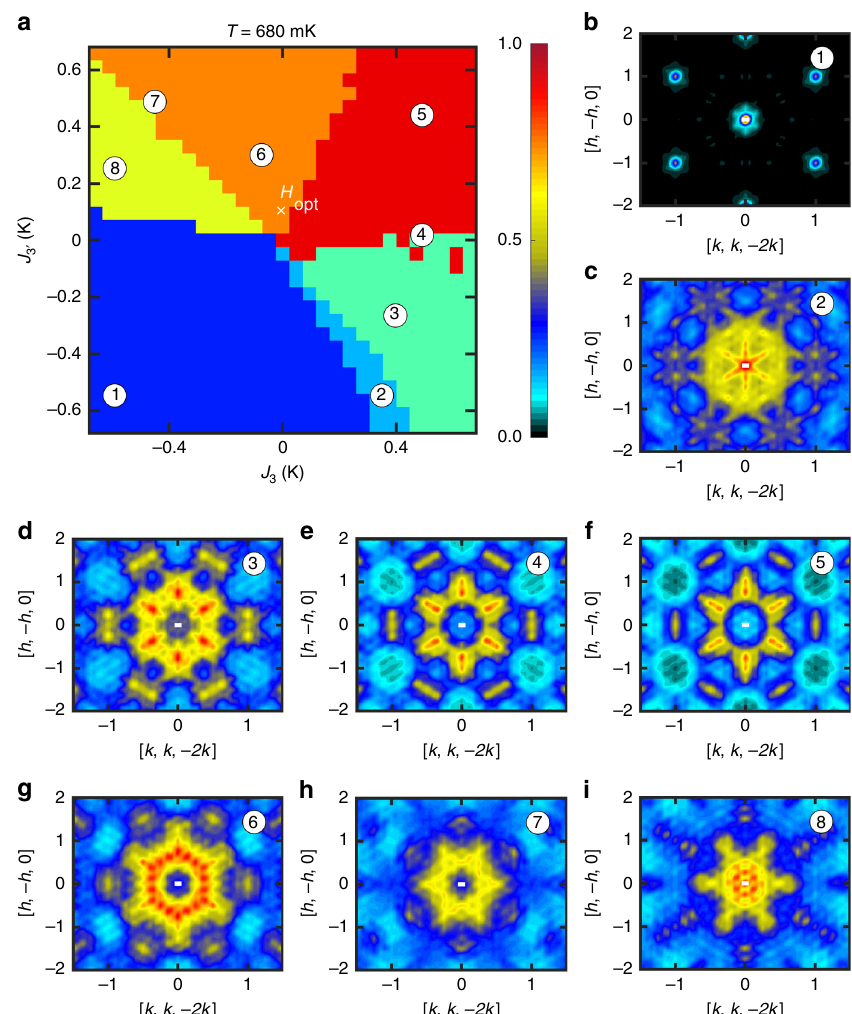
Fig. 6 Map of regimes with different spatial magnetic correlations. The map is generated by varying J 3 and J 3 0 , with the remaining Hamiltonian parameters J 1 , J 2 , and D being fi xed to their optimal values. The colors in a indicate different groups of S ( Q ), which correspond to regimes with different patterns of magnetic correlations. b – i Simulated S ( Q ) data sliced in the high symmetry plane at speci fi c points indexed on panel ( a ). The large dark-blue regime (1) corresponds to long-range ferromagnetic order, as indicated by the Bragg peaks in panel ( b ). c – i Correspond to different patterns of short-range correlations arising from subsets of states that still obey ice rules. The pattern ( g ) falls within the same orange regime as H opt , and qualitatively captures the Coulombic correlations expected for spin ice [cf. experimental scattering data in Fig.